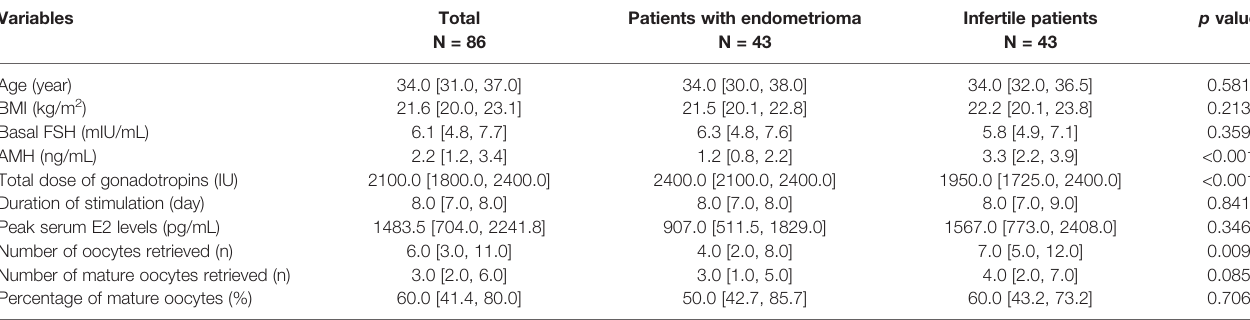
TABLE 3 | Comparison of clinical characteristics and fi rst controlled ovarian stimulation cycle outcomes of patients with endometrioma and infertile patients without endometrioma. Variables Total Patients with endometrioma Infertile